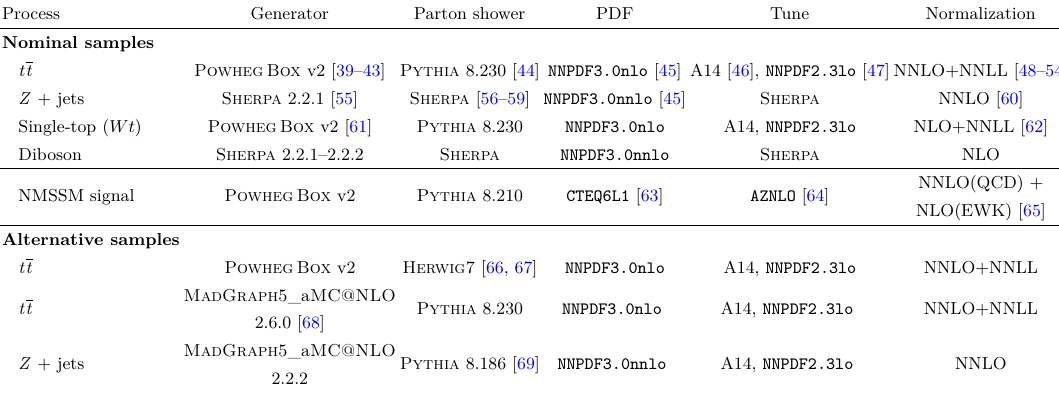
Table 1. Monte Carlo simulated samples used in this analysis. The top section shows the nominal samples used for SM backgrounds and the potential signal process. The bottom section shows alternative SM samples for evaluating the impact of theoretical systematic